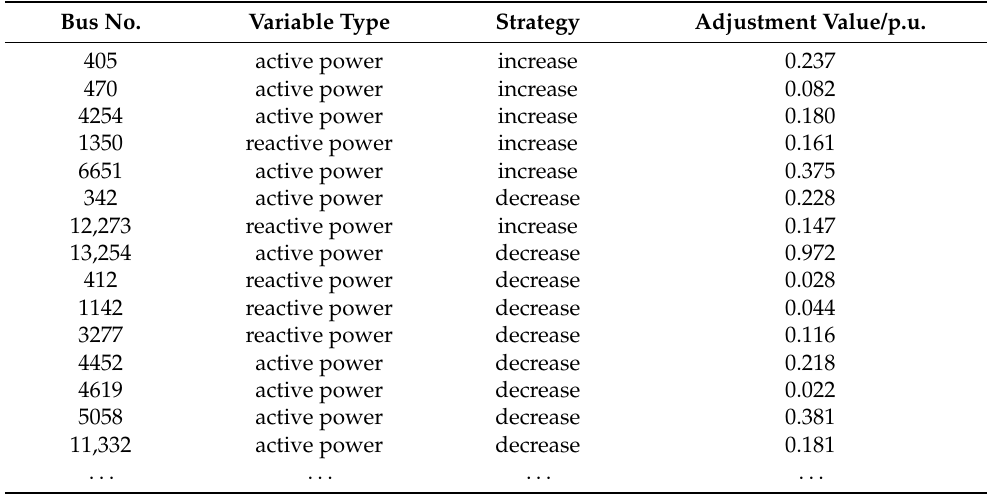
Table 4. Multi-power adjustment